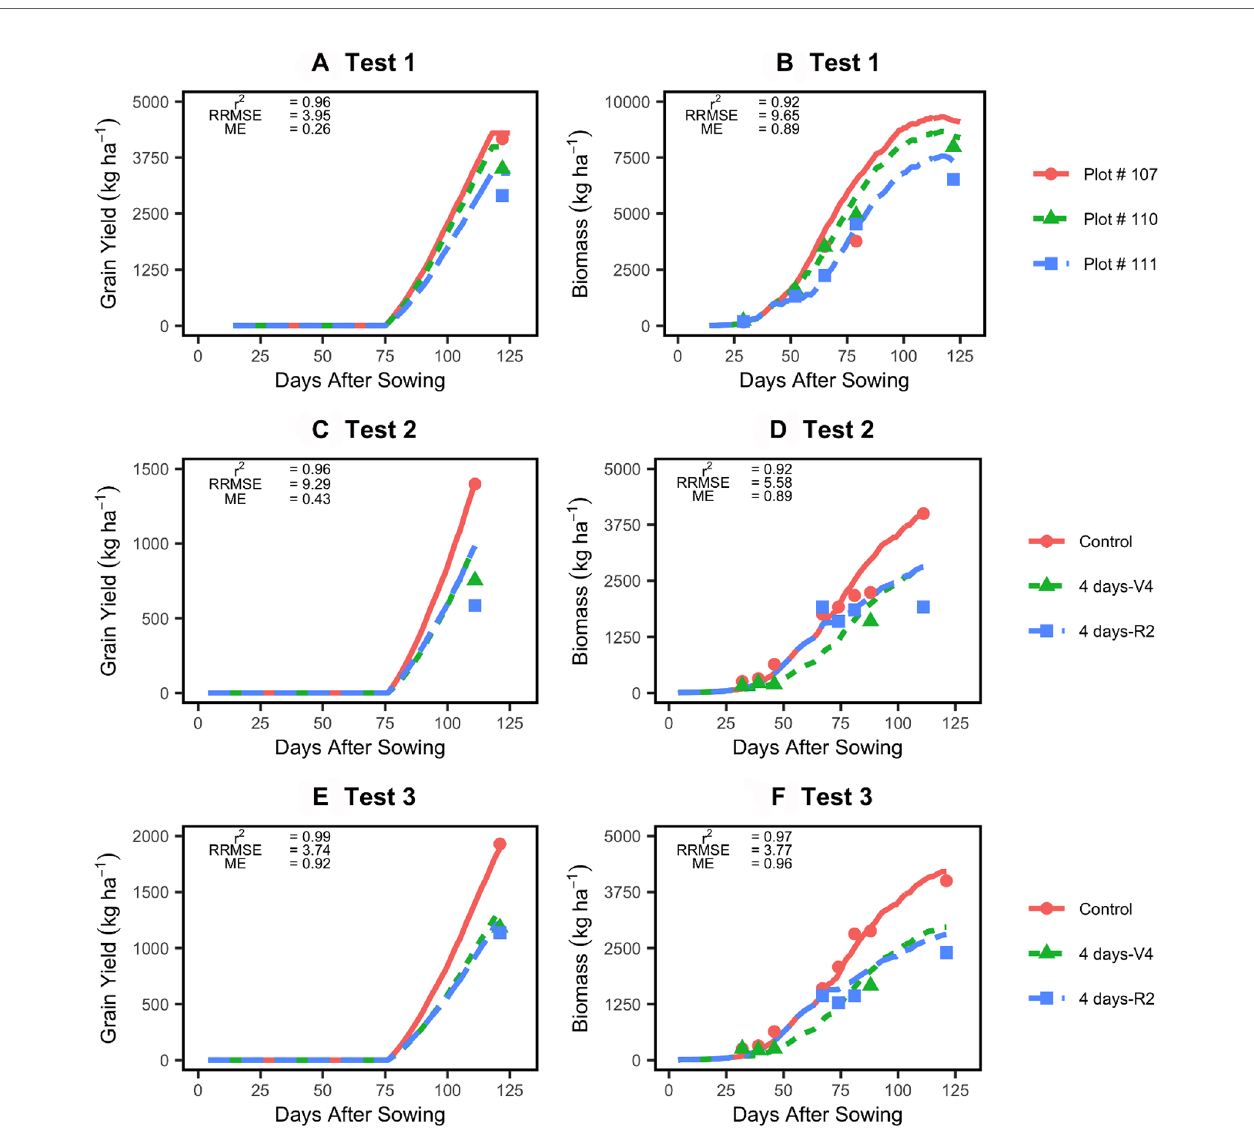
FIGURE 5 | Testing of the improved model (lines) against two independent datasets (points). Left panels show model evaluation for yield (A, C, E) and right panels model evaluation for in-season biomass accumulation (B, D, F) . See Table 1 for experimental